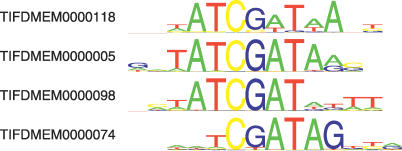
The Largest of 13 Clusters of Similar MotifsClusters were identified by finding significant matches in an all-against-all comparison of 120 inferred motifs.